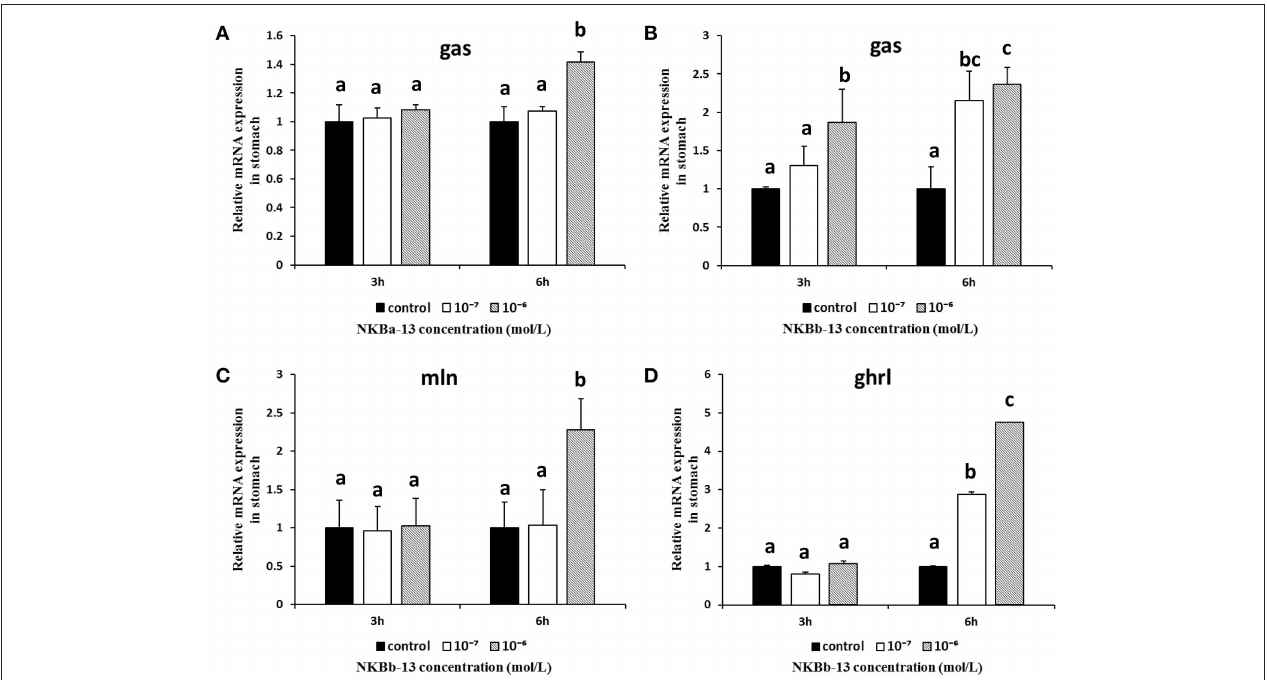
FIGURE 12 | Effect of NKBs on the expression of brain-gut peptide (BGP)-related genes in the stomach. The X axis indicates hours after NKB treatment. (A,B) Effect of NKBa-13 and NKBb-13 on the mRNA levels of gas in the stomach; (C,D) Effect of NKBb-13 on the mRNA levels of gas and ghrl in the stomach; the results are represented as the mean ± SEM and expressed as fold of the expression level in controls. Significant differences are noted by different letters for each concentration ( P <